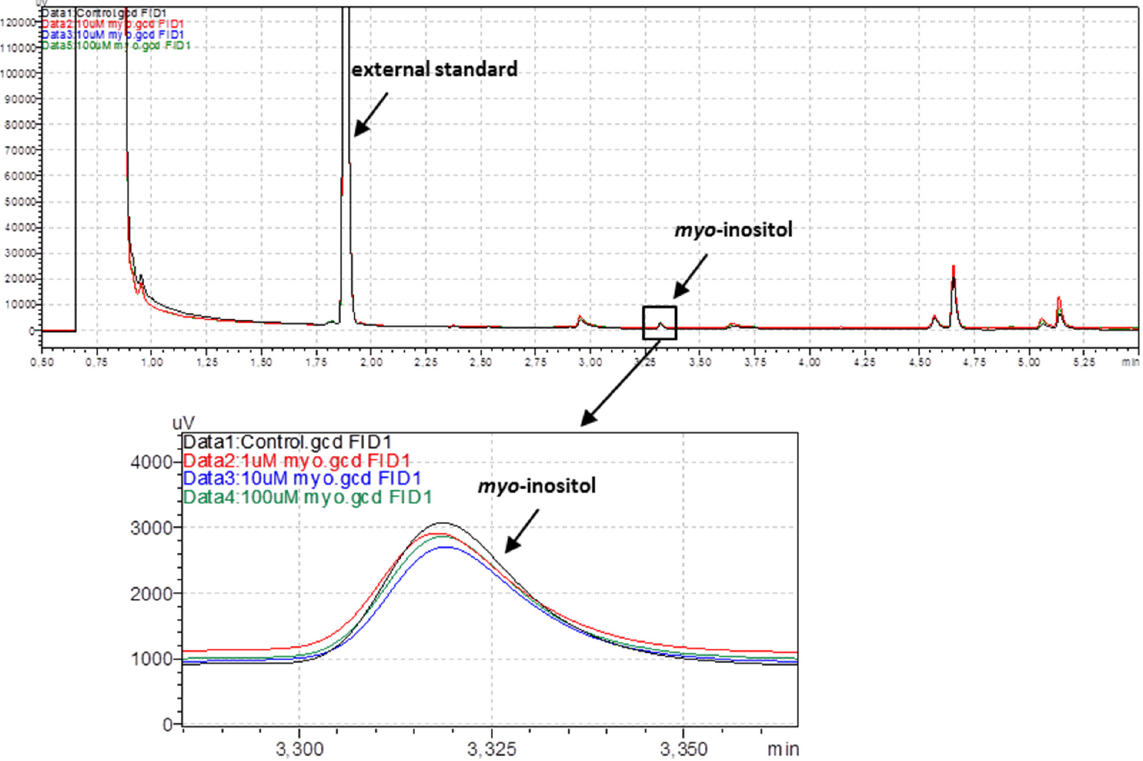
Figure 1. Presence of myo -inositol (0.040 ± 0.002 μ g/mg) in aortic rings (12.55 ± 2.065 mg) analyzed with a gas chromatograph with flame-ionization detector. Control—black line; samples after pre- incubation in myo -inositol solutions (120 min): 1 μ M—red line, 10 μ M—blue line, 100 μ M—green line.